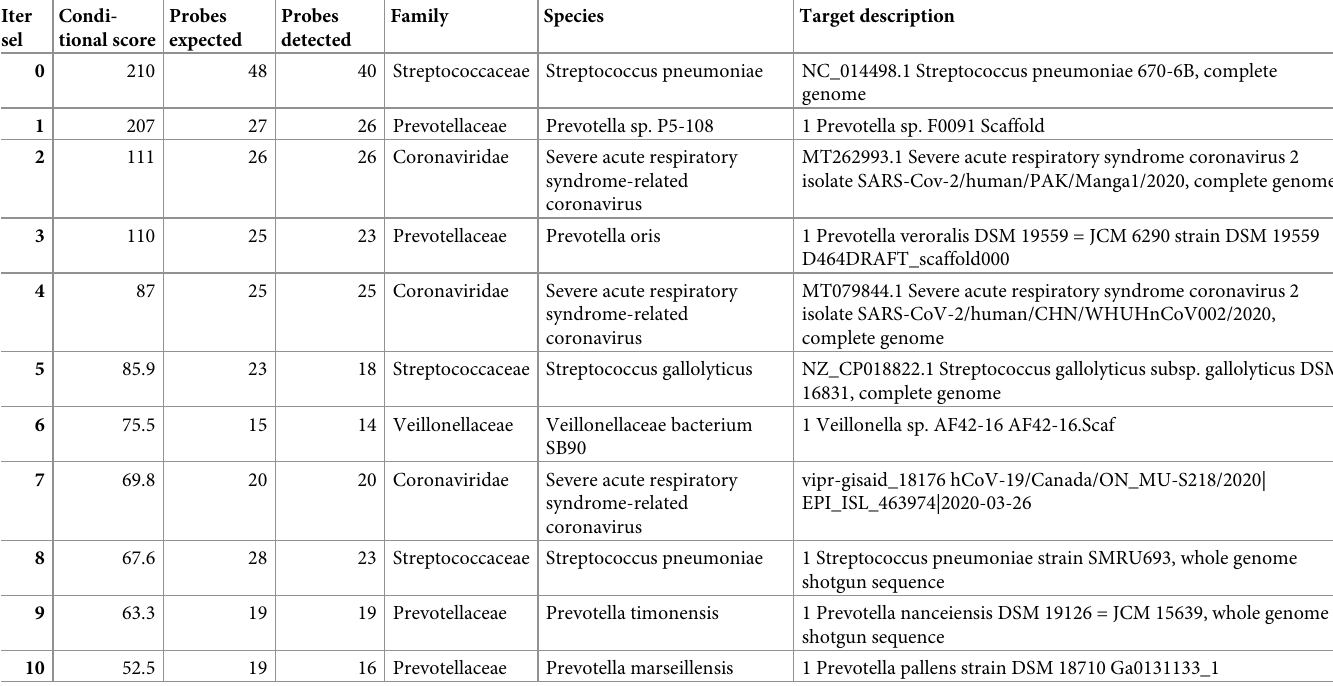
Table 1. LLMDA results summary example. Iter